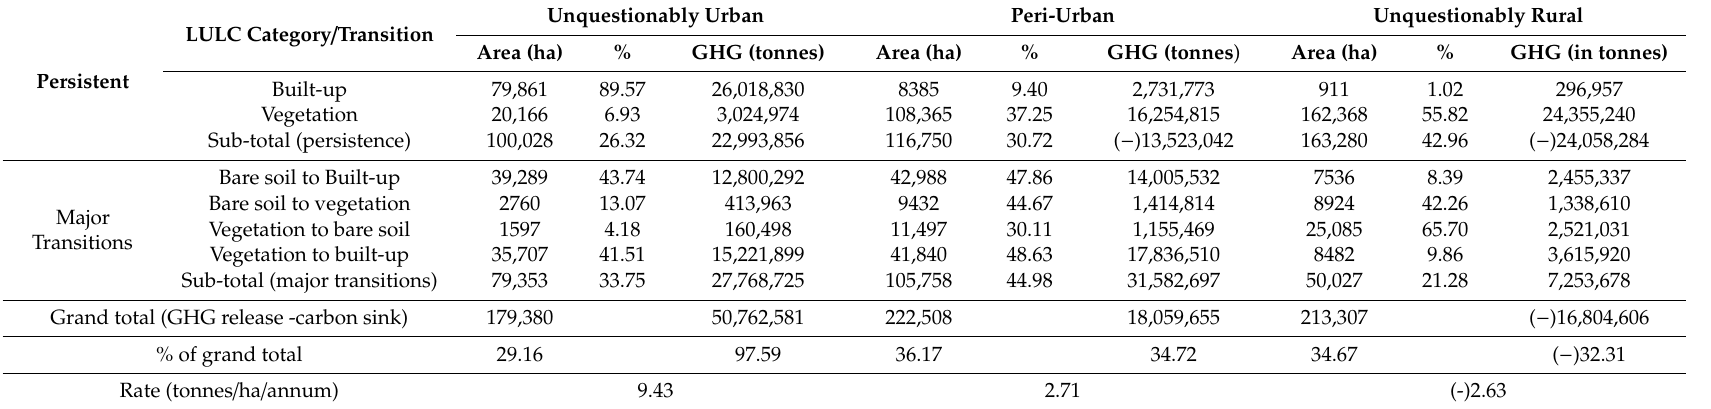
Table 11. Calculating GHG emissions within di ff erent urban growth land use areas between 1989 and